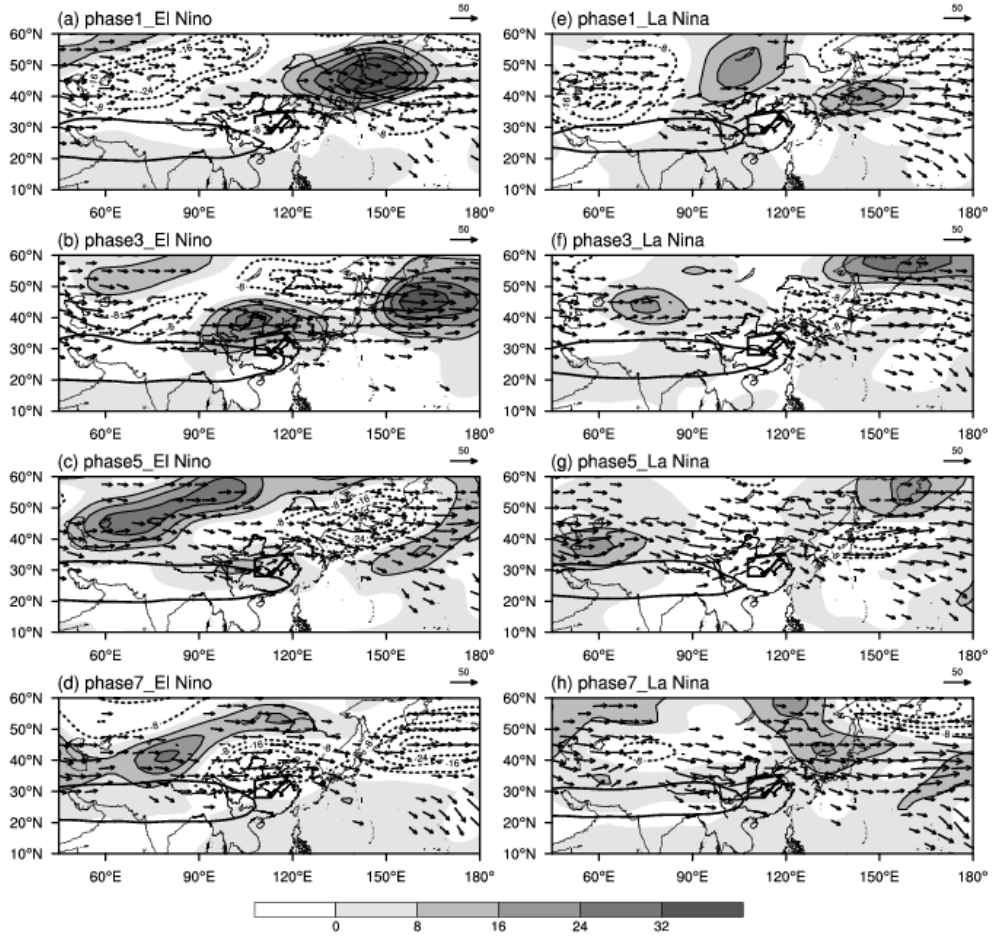
Figure 6. Same as Figure 5, but for the phase synthesis of 10–20 d low-frequency height fields (the shaded areas denote low-frequency height positive anomaly, dotted lines denote negative anomalies, units: gpm), and the two-dimensional wave-activity flux (WAF) fields (vector, WAFs < 5.0 m 2 · s − 2 were not drawn, units: 10 2 m 2 · s − 2 ) at 200hPa, black thick solid line denotes unfiltered 12,520 gpm contour.